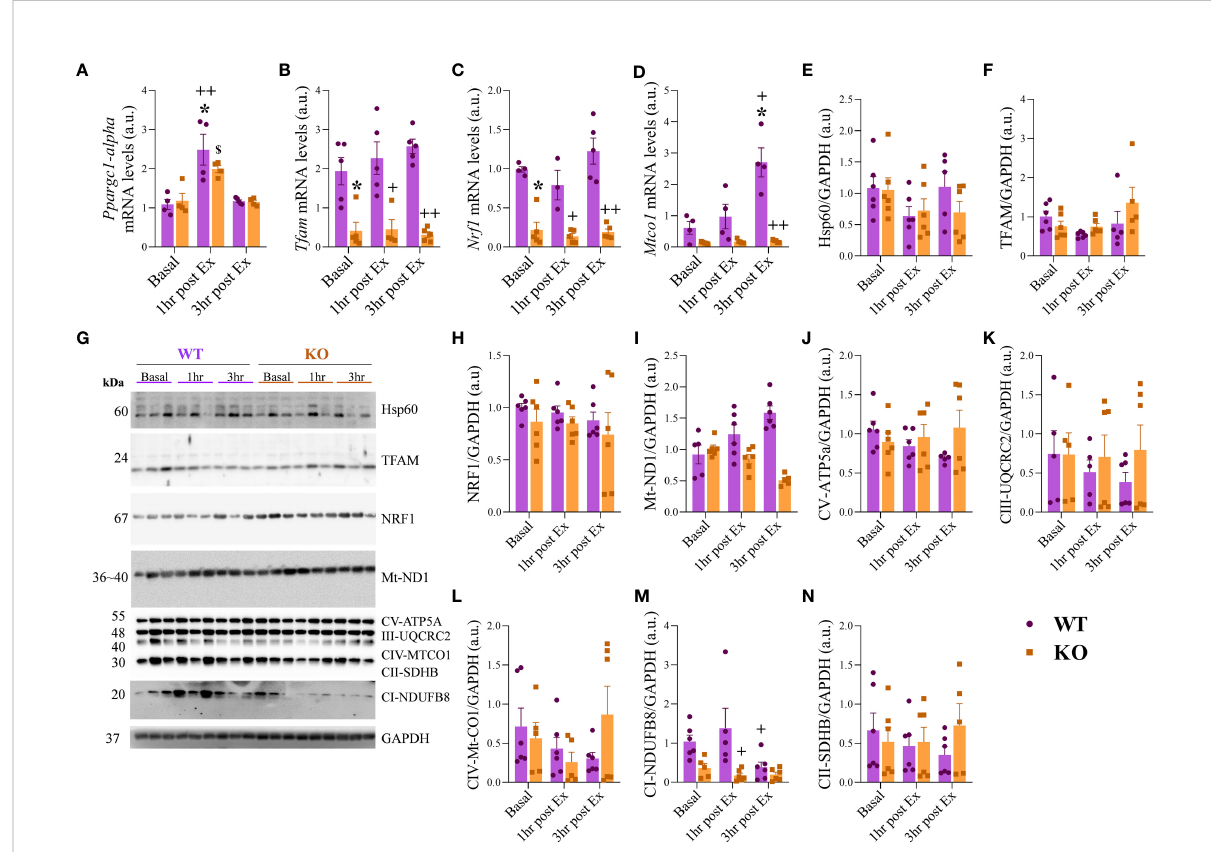
FIGURE 4 mRNA and protein levels related to mitochondrial metabolism. Ppargc1-alpha (A) ; Tfam (B) ; Nrf1 (C) ; Mtco1 (D) . Hsp60/GAPDH (E) ; TFAM/ GAPDH (F) ; Representative membranes (G) ; NRF1/GAPDH (H) ; Mt-ND1/GAPDH (I) ; CV-ATP5a/GAPDH (J) ; CII-UQCRC2/GAPDH (K) ; CIV-Mt- CO1/GAPDH (L) ; CII-SDHB/GAPDH (M) ; CI-NDUFB8/GAPDH (N) . Data correspond to the mean ± SEM of n=4-5 mice/group for RT-qPCR and n=5-6 mice/group for western blotting. *p ≤ 0.05 vs. WT at Basal; +p ≤ vs. WT at 1hr post-Ex; ++p ≤ vs. WT at 3hr post-Ex; $ p ≤ 0.05 vs. KO at 3hr post-Ex. Basal (sedentary; Basal), 1 hour (after 1h of the acute exercise; 1hr post-Ex), and 3 hours (after 3h of the acute exercise; 3hr post- Ex). a.u., arbitrary